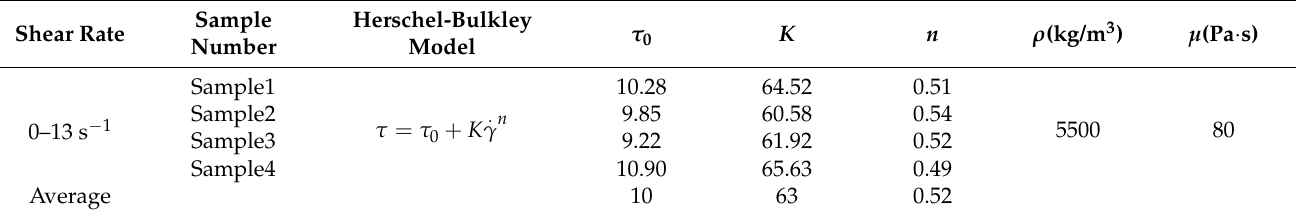
Figure A1. Data points and curve fitting of shear rate and shear stress. According to the curve fitting, three fluid material parameters of Herschel-Bulkley fluids are shown in Table A1. Table A1. Herschel-Bulkley fluid material parameters.